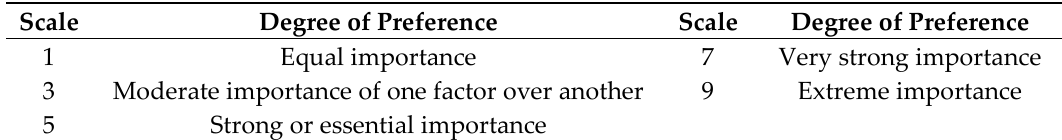
Table 1. Degree of preference to establish criteria